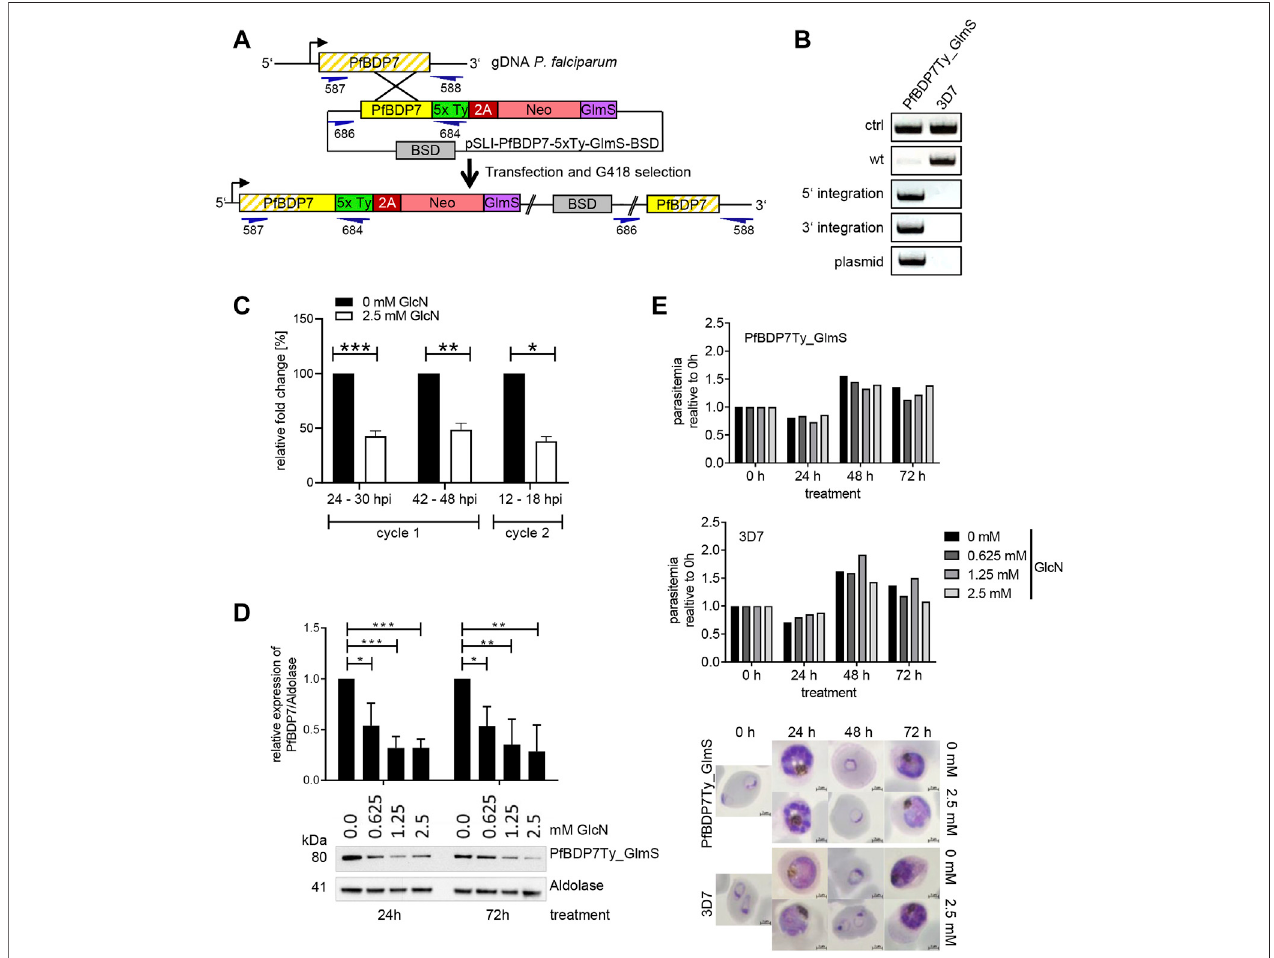
FIGURE 4 | Conditional knock down of PfBDP7 does not affect parasite growth. (A) Scheme of SLI strategy for modi fi cation of the PfBDP7 genomic locus by integration of 5 × Ty epitope tags and a GlmS ribozyme downstream of the 2A skip peptide and the neomycin (Neo) selection cassette. Primer positions for diagnostic PCR are indicated in dark blue, with numbers according to Supplementary Table S1 . (B) Diagnostic PCR screen for plasmid integration in the PfBDP7Ty_GlmS parasite line and (wt = wild type, ctrl = control primers targeting the pfs16 gene). (C) qPCR analysis demonstrates ef fi cient mRNA knock down in parasites treated with2.5 mM glucosamine over two IDCs. Expression data were normalized to seryl-tRNAsynthetase and the enrichment relative tountreated parasites was calculated. Mean and SD of N = 3, unpaired t -test. (D) Glucosamine treatment signi fi cantly reduces PfBDP7 protein expression. Tightly synchronized ring stage PfBDP7Ty_GlmS parasites(0 – 6 hpi)weretreatedfor24or72 hwithincreasingconcentrationsofglucosamine(GlcN)rangingfrom0to2.5 mM,andproteinexpressionwasmonitoredby westernblotwithaTyand aaldolase antibodies. Densitometryresults aremean andSD of N =3replicates, unpaired t -test. (E) Parasitegrowth ofPfBDP7Ty_GlmS and 3D7 control parasites treated with increasing concentrations of GlcN was examined after 24, 48, and 72 h by fl ow cytometry. After 24 h, the cultures were split 1:5 to prevent overgrowth. Parasite development was monitored in parallel by Giemsa staining. Representative images of cultures treated with 0 or 2.5 mM GlcN are shown.